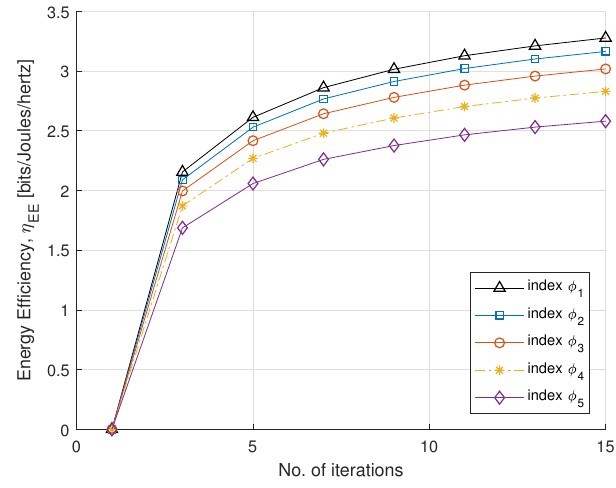
Figure 4. EE vs. number of iterations.